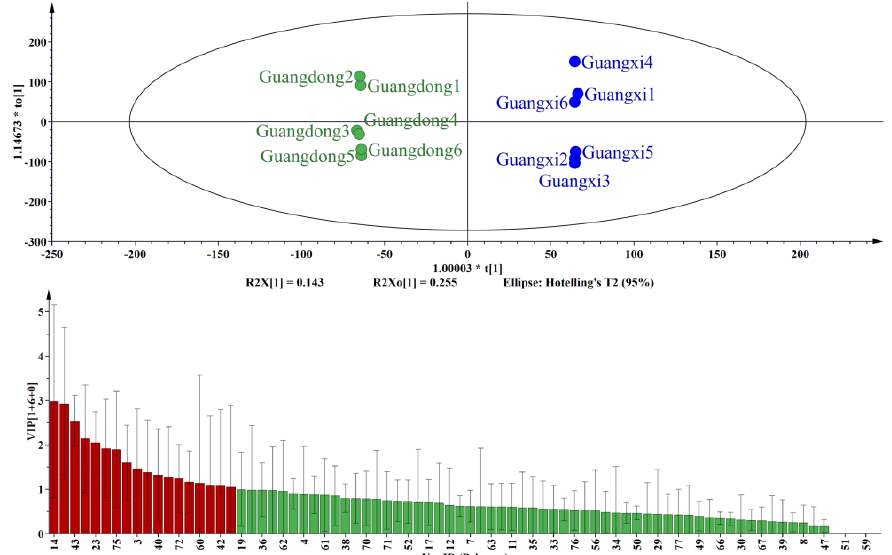
Figure 3. OPLS-DA analysis and VIP diagram of brown sugar in Guangdong and Guangxi.